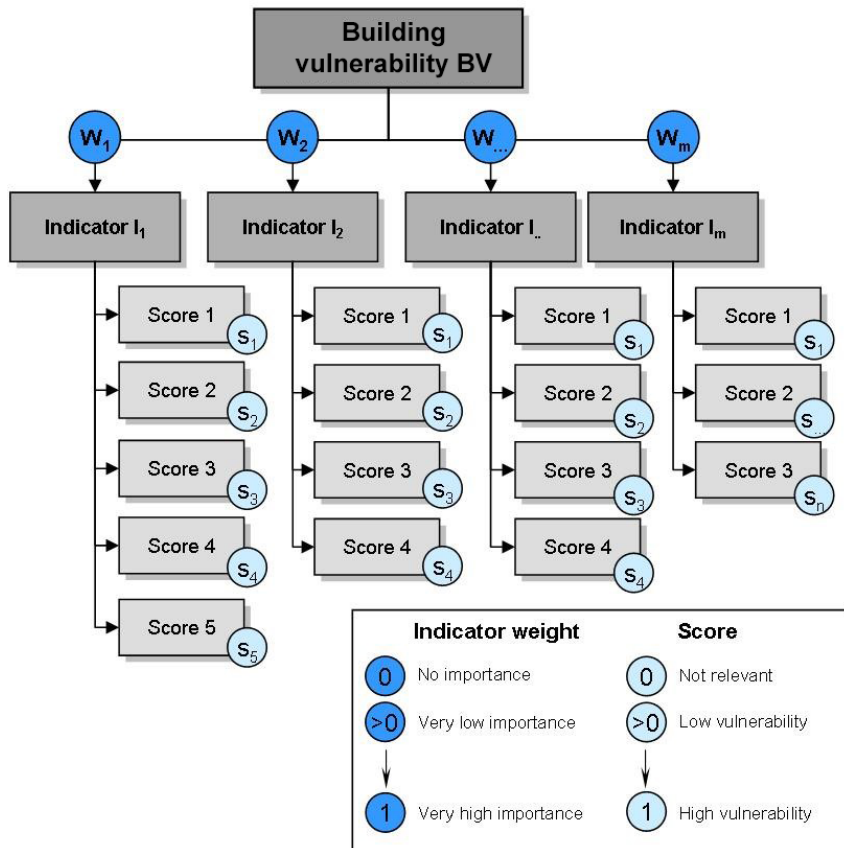
Figure 1. The concept of the IBM (Kappes et al.,